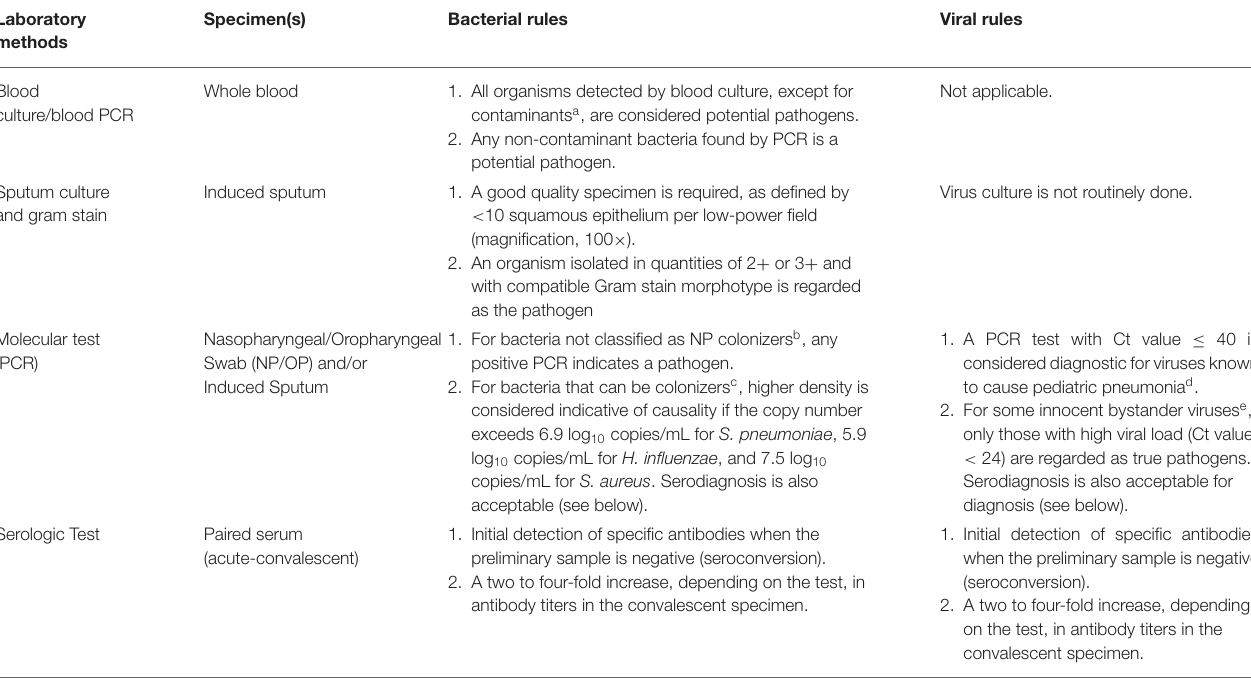
TABLE 1 | Rules for identification of causative pathogens in childhood